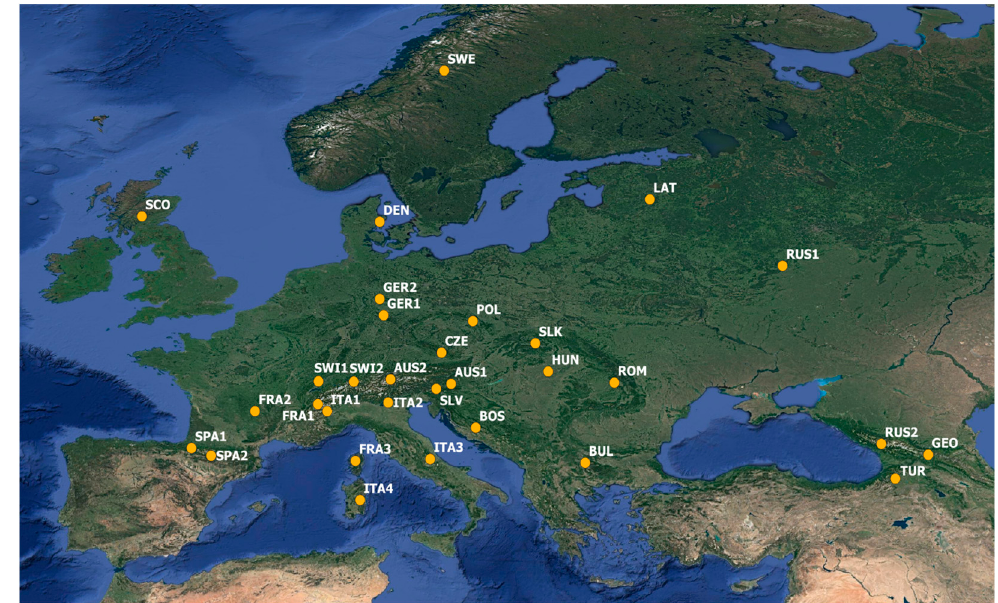
Figure 2. Distribution of study areas across Europe. Table 2. European grassland sites selected for phenological analysis during the period 2001–2021.